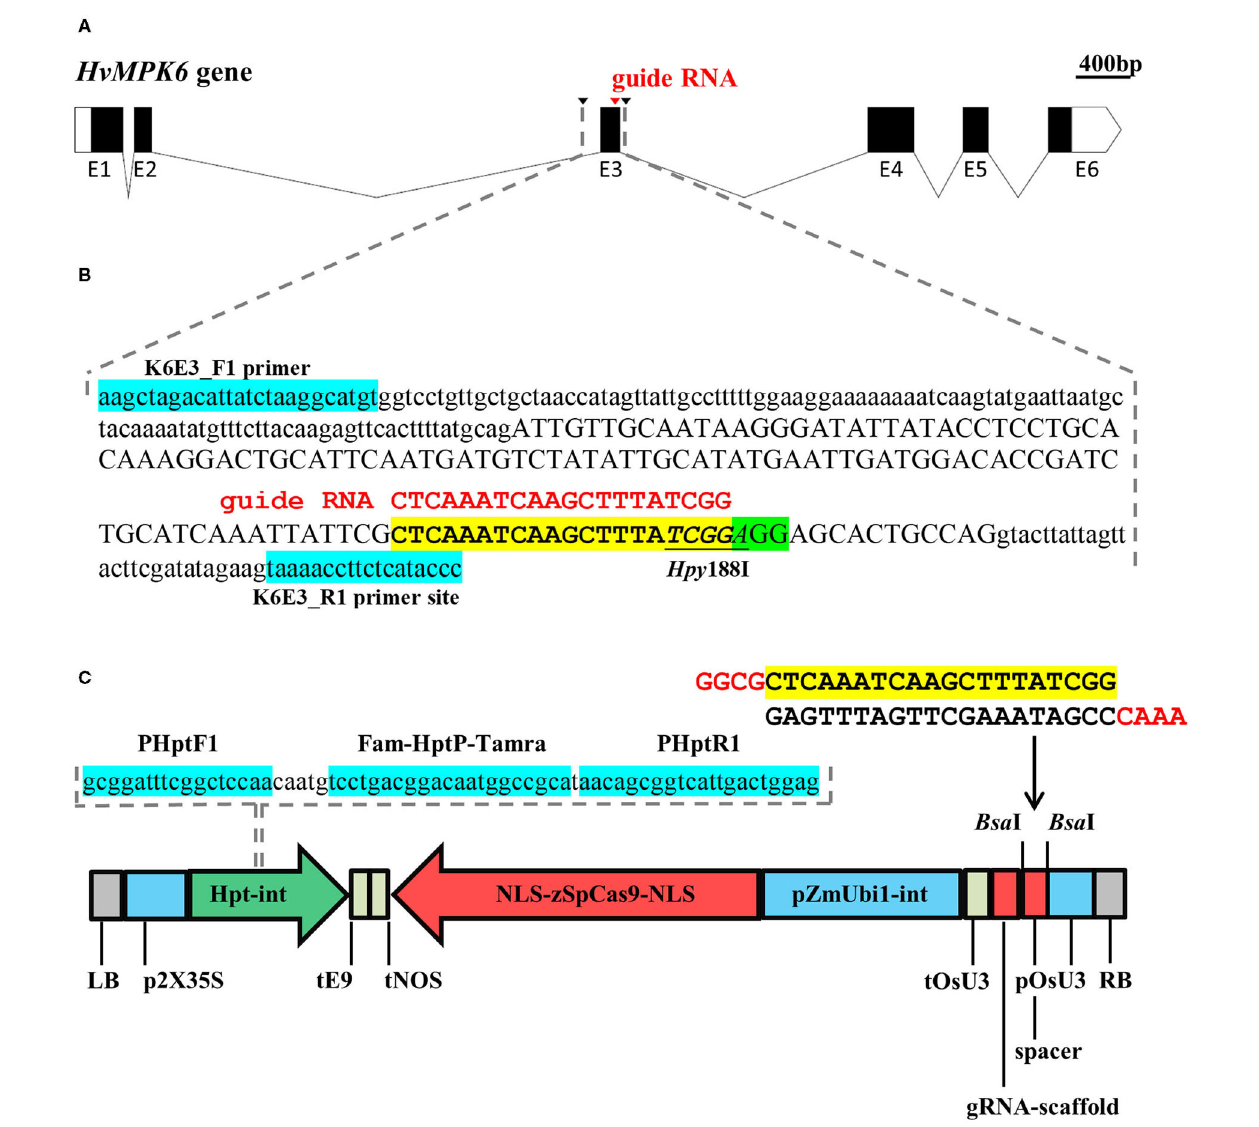
FIGURE 1 | Schematic overview of the targeting of the HvMPK6 gene with a CRISPR/Cas9 technology and on-target mutation detection. (A) Structure of the transcribed region of the Golden Promise (GP) HvMPK6 gene (AK376245.1.mrna1_gpv1_chr7H_26521825_26529501_0, https://ics.hutton.ac.uk/gmapper/). Black rectangles indicate coding exons or coding parts of the exons and open rectangles indicate 5 ′ and 3 ′ untranslated regions (UTRs). Exons are indicated with “E” and exon number below the rectangles. Introns are shown as solid lines. The on-target site of the designed guide RNA (gRNA) is indicated by a red arrowhead in the coding region of the third exon (E3). Black arrowheads indicate positions of the K6E3_F1 and K6E3_R1 primers used for the PCR-based detection of on-target mutations. (B) Schematic representation of the 316-bp genomic DNA fragment covering the on-target region. Dashed gray lines indicate the position of the fragment in (A) drawing. The nucleotide sequence of the respective GP HvMPK6 gene fragment (plus strand) is shown with the exon three sequence in an upper case and the surrounding intron sequences in a lowercase. The position of the gRNA on-target site and the protospacer adjacent motif (PAM) site is shown with a yellow and green box, respectively. A 20-bp gRNA sequence is typed in red and shown above the on-target site. The diagnostic restriction site of the Hpy 188I endonuclease is underlined. Turquoise boxes indicate flanking positions of the K6E3_F1 and K6E3_R1 primers. (C) Schematic representation of the CC9-K6E3 construct used for the stable Agrobacterium tumefaciens -mediated transformation of barley. The construct is based on pSH91 and p6i-d35S-TE9 vectors. The sequence of the HvMPK6 spacer oligonucleotide heterodimer is shown above the construct drawing with a 20-bp gRNA indicated in a yellow box and 5 ′ overhangs typed in red. The spacer was cloned between the Bsa I sites of the construct (indicated with arrows) to allow for the expression of gRNA (including gRNA-scaffold) under the control of the Oryza sativa snRNA U3 promoter (pOsU3) and terminator (tOsU3). The expression of the Zea mays codon optimized version of the Streptococcus pyogenes Cas9 endonuclease gene (NLS-zSpCas9-NLS) is driven by the maize polyubiquitin gene promoter 1 including intron (pZmUbi1-int) and a nopaline synthase terminator (tNOS). Double cauliflower mosaic virus promoter (p2X35S) and rbcS-E9 gene terminator (tE9) control the expression of the hygromycin phosphotransferase gene including modified IV2 intron (HPT-int). NLS, nuclear localization signal; LB, left border; RB, right border. The nucleotide sequence of the HPT gene DNA fragment, which was used as a template for multiplex TaqMan quantitative PCR- (qPCR-) based transfer DNA (T-DNA) genotyping, is shown above the construct. Dashed lines indicate the location of the fragment in the construct. Positions of the primers and TaqMan probe are shown with turquoise boxes.